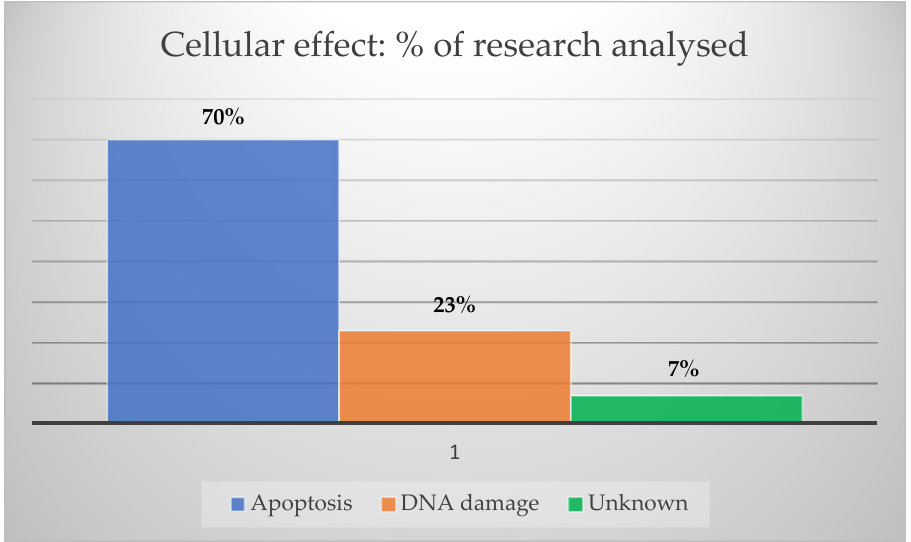
Figure 7. Cellular death mechanisms. The percentage of the most common cancer cellular death mechanisms by AuNPs in research papers used in this state-of-the-art review.